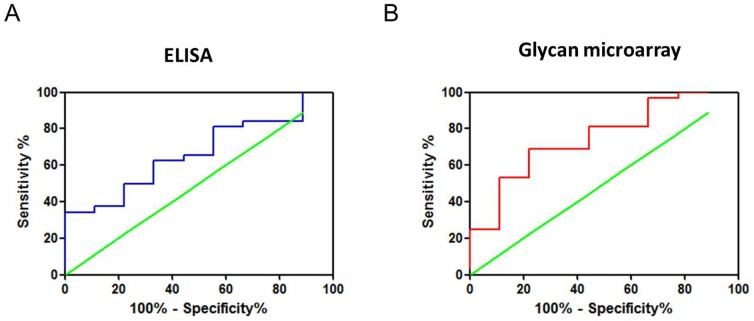
Receiver–operator characteristic curves for AFP-L3% in patients.(A) ELISA revealed an AFP-L3% cut-off value of 1.873% as a tumor marker for HCC, which had a sensitivity of 50% and specificity of 77.78%. Under these conditions, the area under the receiver–operator characteristic curve was 0.6667 (0.4856–0.8477, 95% CI, P = 0.13). (B) The glycan microarray revealed an AFP-L3% cut-off value of 0.6388 as a tumor marker for HCC, which had a sensitivity and specificity of 53.13% and 88.89%. Under these conditions, the area under the receiver–operator characteristic curve was 0.75 (0.5727–0.9273, 95% CI, P<0.05).